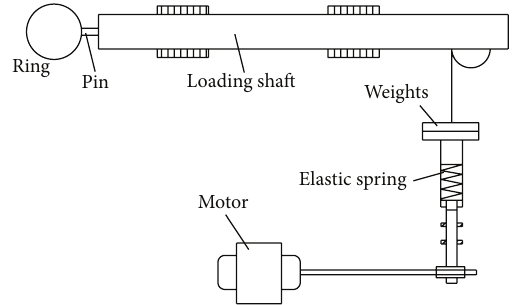
Figure 3: The schematic of the pin-on-ring